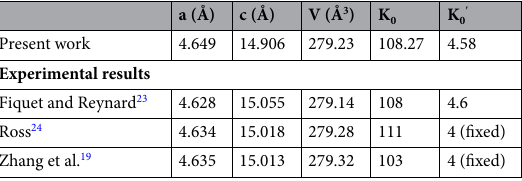
Table 1. Calculated structural parameters of magnesite along with the experimental